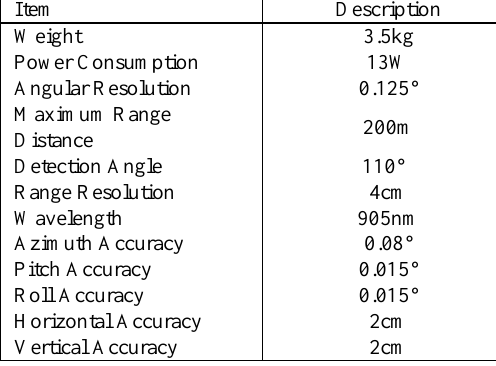
Table 1 . Specifications of the AOEagle